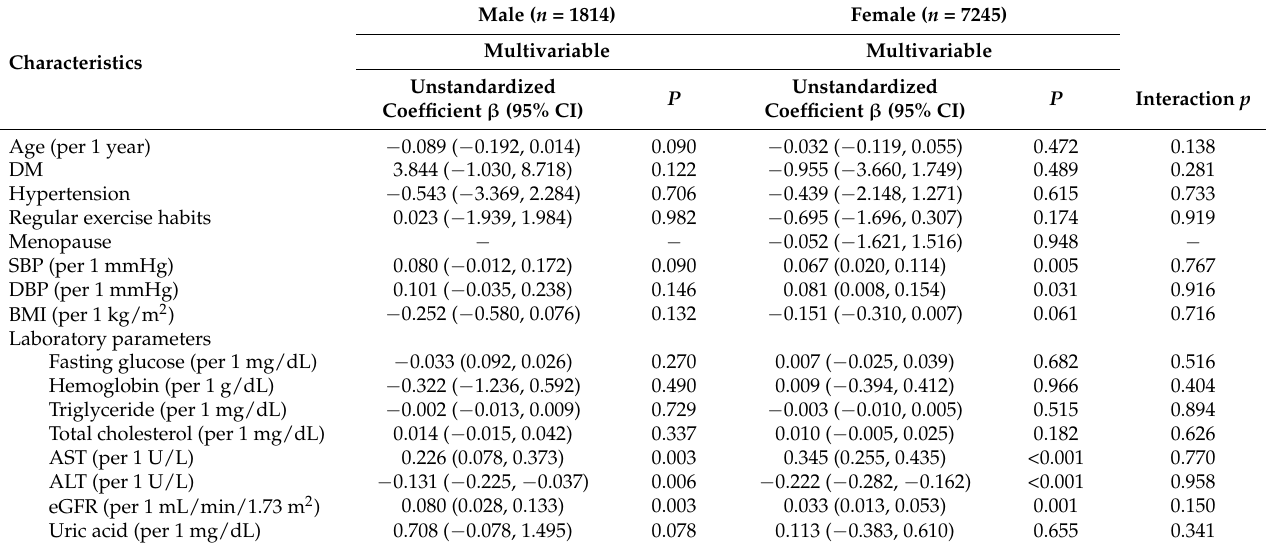
Table 3. Determinants for (cid:52) FEV1/FVC in different genders using multivariable linear regression analysis.